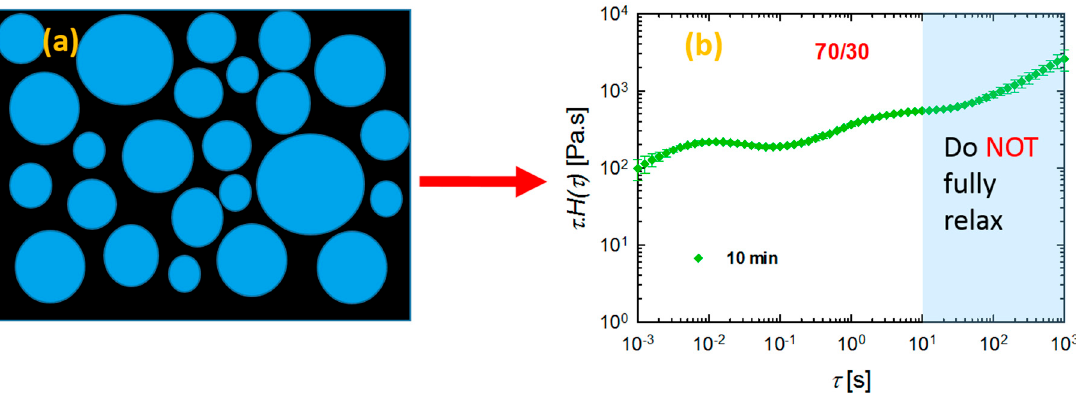
Figure 7. Schematic presentation of a relaxation spectra of a blend with a condensed morphology where the round-shaped domain phases are located in very close vicinity to one another as in the case of the 10 min processed (70/30) and 5 min and 10 min processed (50/50) PLA/PVDF blends.